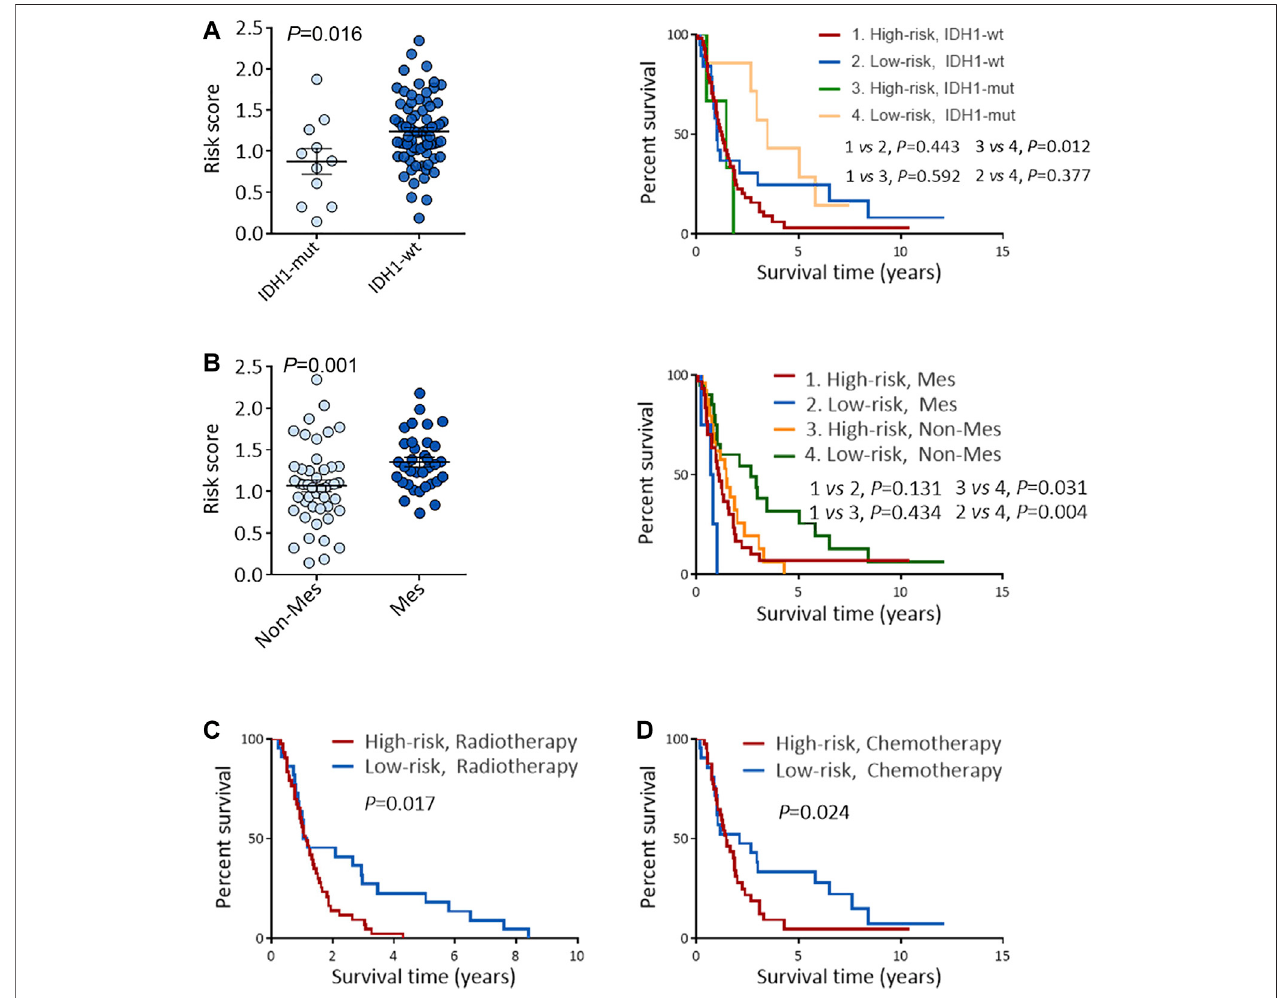
FIGURE 7 | Performance of risk score in predicting the survival and treatment response in CGGA GBM cohort. (A) Risk scores in IDH1-mut GBM and IDH1-wt GBM (left), and KM OS analysis of CGGA GBM patients strati fi ed by risk score combined with IDH1 status (right). (B) Risk scores in Non-Mes GBM and Mes GBM (left), KM OS analysis of CGGA GBM patients strati fi ed by risk score combined with expression subtypes. (C – D) KM OS analysis of CGGA GBM patients with radiotherapy (C) , or TMZ chemotherapy (D) according tothe riskscore.KM, Kaplan-Meier; OS, overall survival; IDH, isocitrate dehydrogenase; IDH1-wt, IDH1-wild type; IDH1- mut, IDH1-mutation; Mes, mesenchymal; Non-Mes, non-mesenchymal; TMZ, temozolomide. Data are shown as mean ± SEM.